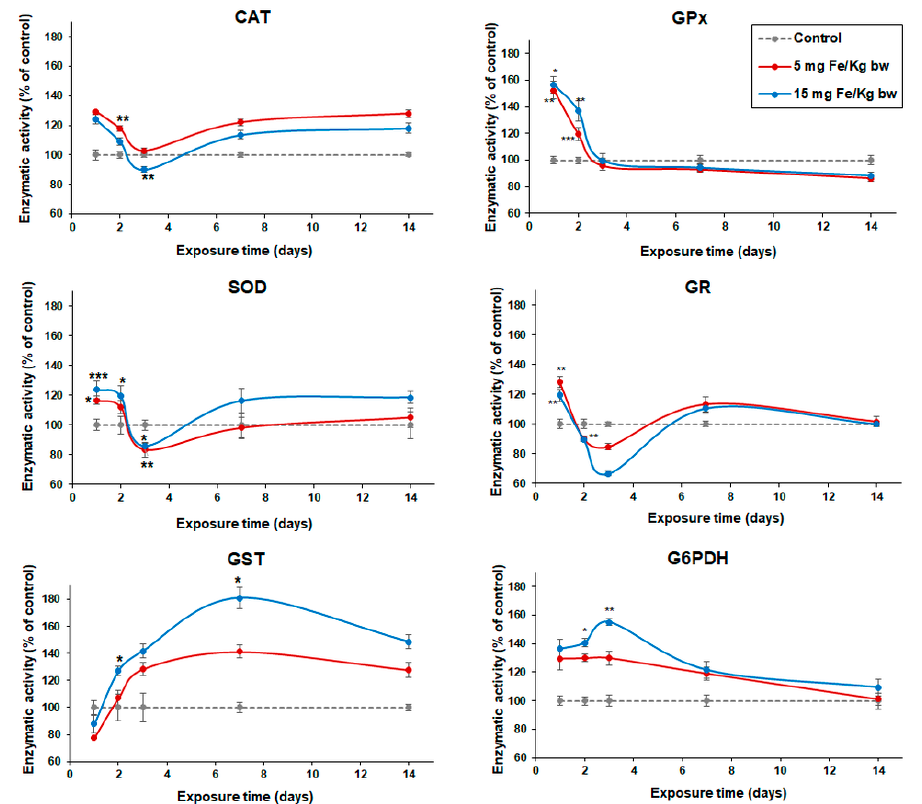
Figure 6. Variation of enzymatic activity of CAT, SOD, GPx, GR, GST, and G6PDH in the liver of CD1 mice treated with 5 and 15 mg Fe / kg bw of MNP-DSPE-PEG after 1, 2, 3, 7, and 14 d from the administration. Values are represented as mean ± standard deviation (SD) and are expressed as a percentage of control; the results were considered statistically significant when * p < 0.05; ** p < 0.01; *** p < 0.001 versus the control group.